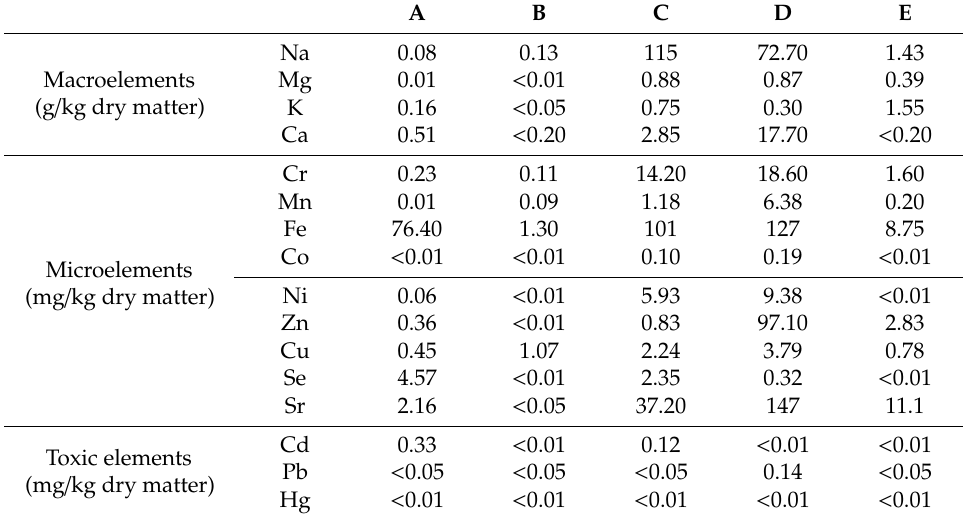
Table 3. Mineral compositions for commercial samples A and B from Sigma and Norland, respectively, and C, D, and E from different extraction protocols.